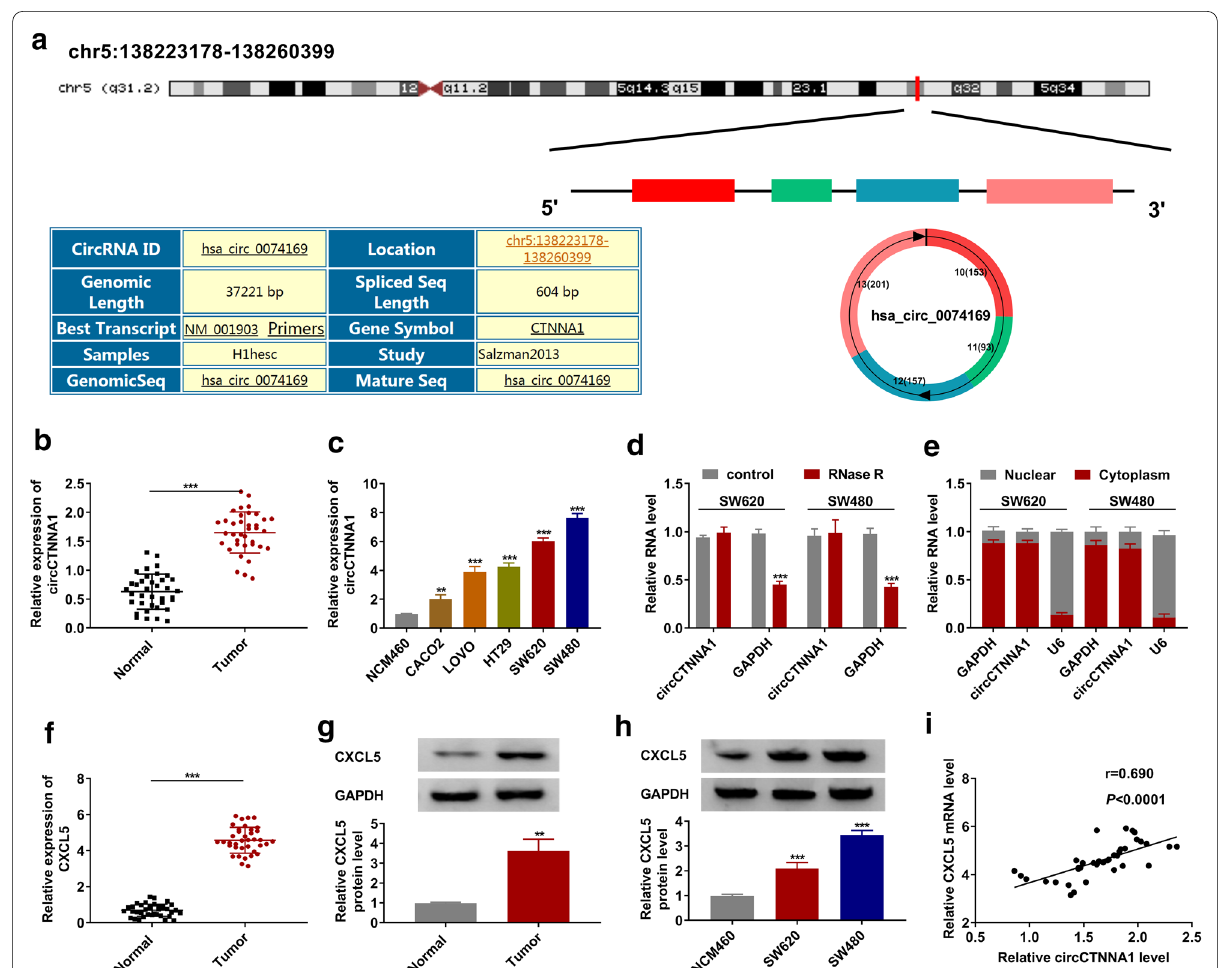
Fig. 1 The expression of circCTNNA1 and CXCL5 in CRC tumor tissues and cells. a The diagram depicting the structure of the CTNNA1 gene and the structure of the circCTNNA1. b The expression of circCTNNA1 in CRC tumor tissues (Tumor) and adjacent normal tissues (Normal) was determined by qRT-PCR. c QRT-PCR was employed to detect the circCTNNA1 expression in NCM460 cells and CRC cell lines (CACO2, LOVO, HT29, SW620 and SW480). d RNase R assay was used to evaluate the stability of circCTNNA1 in SW620 and SW480 cells. e Subcellular localization assay was performed to confirm the distribution of circCTNNA1 in the nuclear and cytoplasm of SW620 and SW480 cells. f , g The mRNA and protein expression levels of CXCL5 in CRC tumor tissues (Tumor) and adjacent normal tissues (Normal) were examined using qRT-PCR and WB analysis. h WB analysis was used to test CXCL5 protein expression in NCM460 cells and both CRC cell lines (SW620 and SW480). i Pearson coefficient correlation was used to analyze the correlation between circCTNNA1 and CXCL5. ** p < 0.01, *** p <